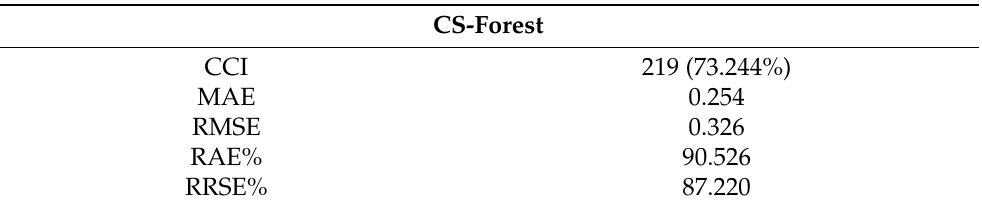
Table 19. CCI and Error Rates details achieved via CS-Forest.